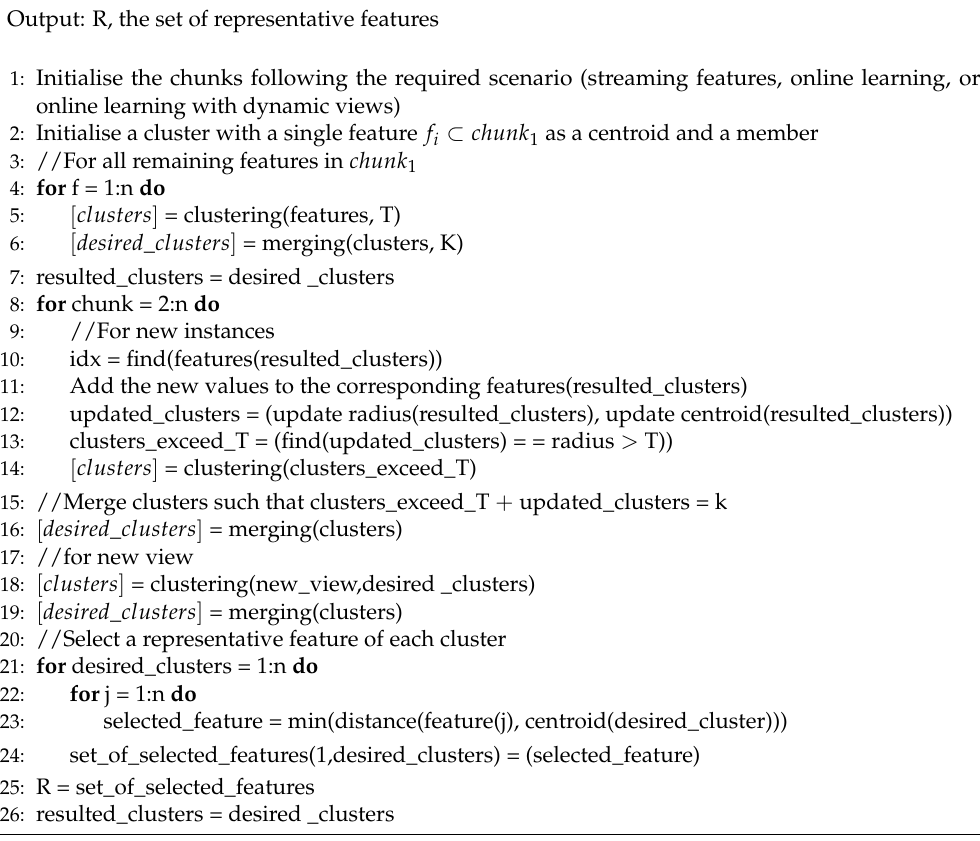
Algorithm 1 The pseudocode of UFODMV